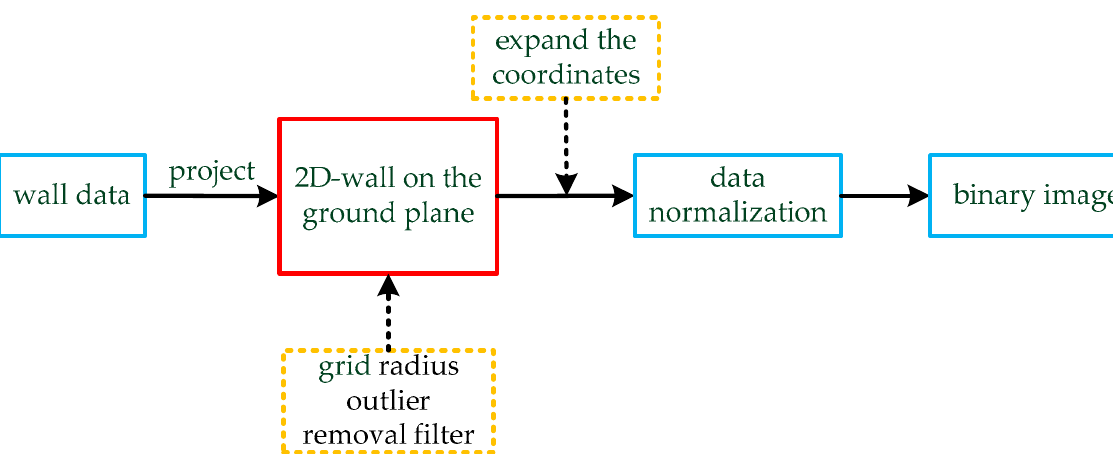
Figure 5. The process of data conversion. The wall data are projected on the ground plane, which was fitted in the previous section. The two-dimensional data are processed by a grid radius outlier removal (GROR) filter, and the coordinate values are enlarged by appropriate multiples. Finally, the data are normalized and transformed into a binary